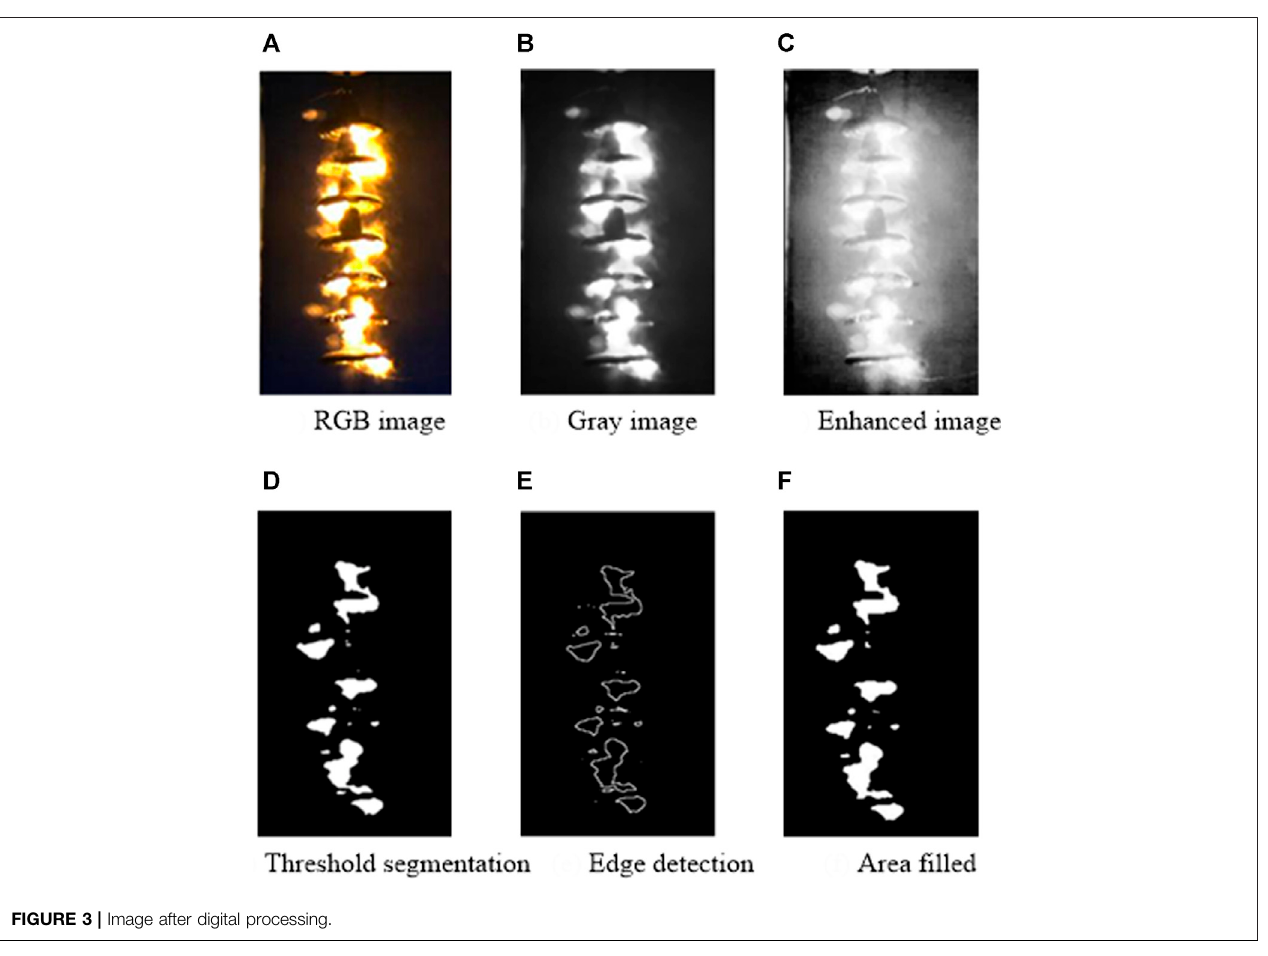
FIGURE 3 | Image after digital processing.